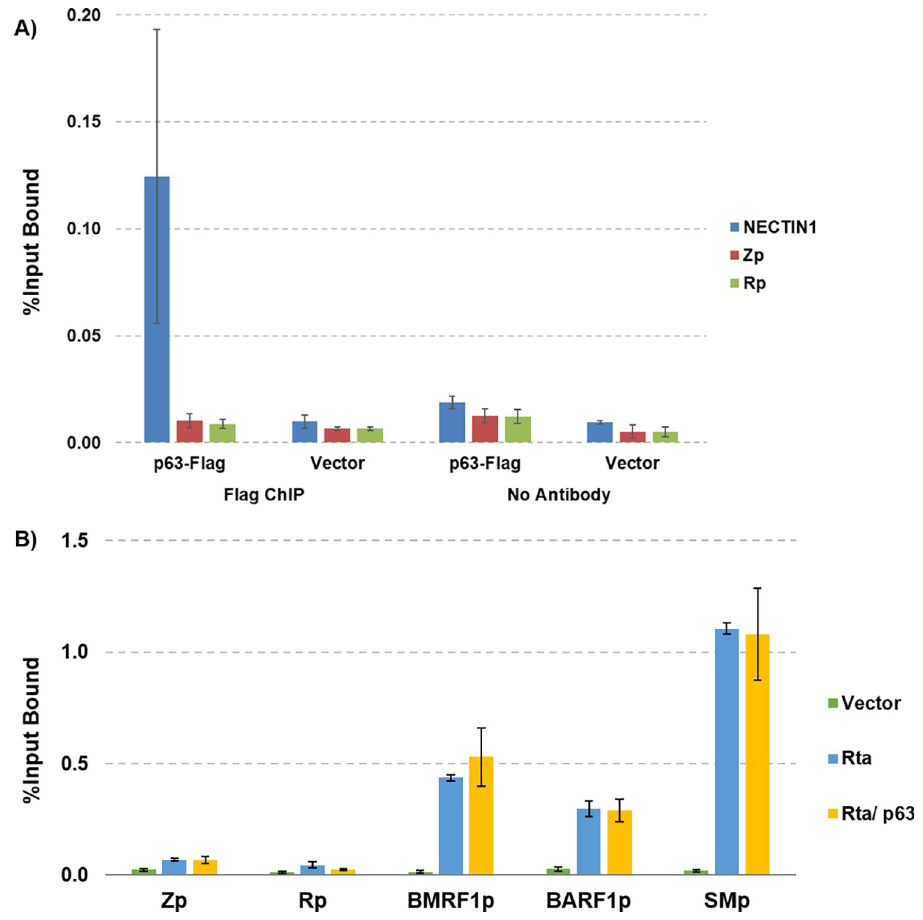
Fig 6. Δ Np63 α does not bind directly to the EBV immediate-early gene promoters or prevent R binding to the EBV genome. A) AGS-Akata cells were transfected with a FLAG-tagged Δ Np63 α vector or a control vector, and two days after transfection a ChIP assay was performed as described in the methods using an anti-FLAG antibody. qPCR was conducted to determine Δ Np63 α occupancy of EBV lytic gene IE promoters Zp and Rp, in addition to NECTIN1, a known Δ Np63 α binding site. B) CNE-2-Akata cells were transfected with vector control or with a FLAG-tagged R expression vector in the presence or absence of Δ Np63 α , and a ChIP assay was performed as described in the methods using an anti-FLAG antibody. qPCR was performed in the ChIP samples to examine R association with the EBV Z promoter, R promoter, BMRF1 promoter, BARF1 promoter, and BMLF1 (SM) promoter. The experiments shown are representative of two independent experiments and the error bar indicates standard error of the mean within experiments. To determine the region(s) of Δ Np63 responsible for the suppression of EBV lytic reactiva- tion, we transfected human Δ Np63 α , mouse Δ Np63 α , and mouse Δ Np63 β isoforms into NOKs-Akata cells with or without R. We found that, like human Δ Np63 α , mouse Δ Np63 α inhibits R-mediated initiation of the lytic replication cycle. However, the mouse Δ Np63 β iso- form, which is missing 121 amino acids of the C-terminal domain of Δ Np63 α , failed to do so ( Fig 7 ). Additionally, TAp63 α also inhibited R-induced lytic reactivation similarly to Δ Np63 α , indicating that TAp63 α may also be an inhibitor of lytic reactivation. Δ Np63 α and TAp63 α are identical at the C-terminal domains, which contain sterile alpha motif (SAM) and the post- sterile alpha motif domains, features that Δ Np63 β lacks. SAM motifs in p63 α isoforms provide docking sites for proteins containing SAM motifs, indicating that a protein-protein interaction could be mediating Δ Np63 α and TAp63 α lytic repression [82].